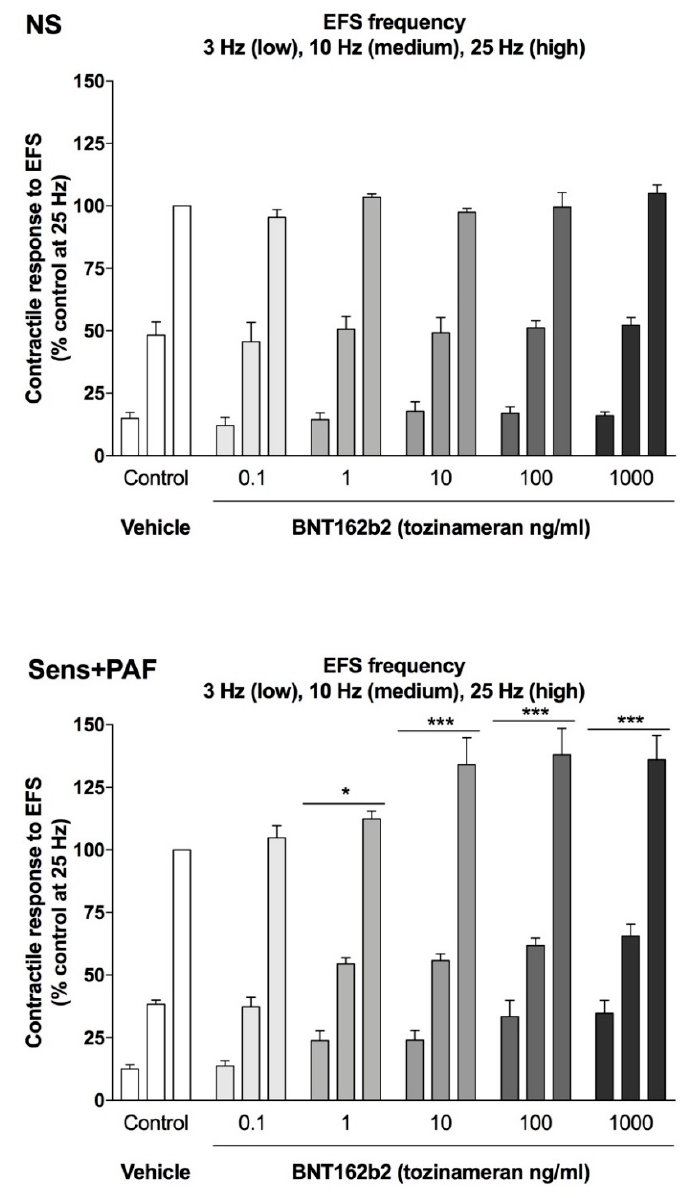
Figure 4. Effect of BNT162b2 on the parasympathetic contractile response induced by EFS 3–25Hz in NS and sens+PAF isolated airways. * p < 0.05 *** p < 0.001 vs. control; results reported as mean ± SE of n = 5 human isolated sub-segmental bronchi. EFS: electrical field stimulation; NS: non-sensitized; PAF: platelet-activating factor; SE: standard error; sens+PAF: passively sensitized plus PAF chal- lenge.